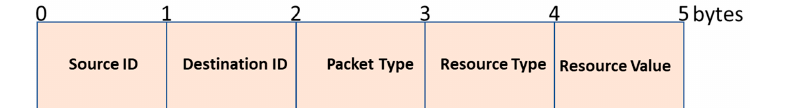
Figure 19. The packet format of U-NMS.